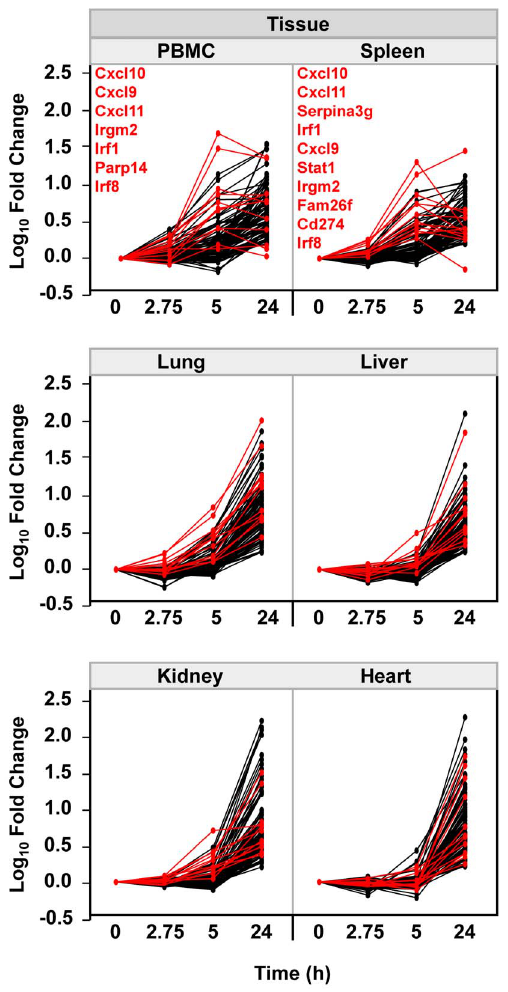
Figure 2. Tissue-specific parallel plots of the 103 probesets that met selection criteria. Expression levels were normalized to the time 0 h control condition to emphasize change over time from baseline. Probesets with peak expression before 24 h in any tissue are displayed in red. Notably, 12 probesets representing 11 unique genes (Cxcl9, Cxcl10, Cxcl11, Cd274, Fam26f, Irf1, Irf8, Irgm2, Parp14, Serpina3g, and Stat1) peaked at 5 h post-staphylococcal enterotoxin B (SEB) challenge in PBMCs and/or spleen as indicated. Gene symbols (in red) are displayed vertically from highest to lowest fold-change at 5